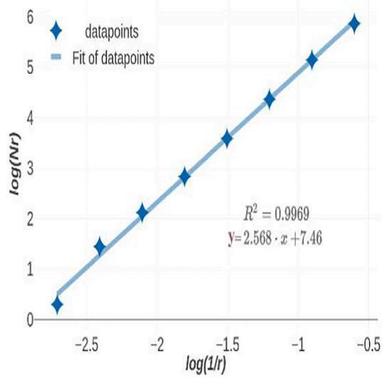
The fitting curve between log (Nr) and log (1/r).